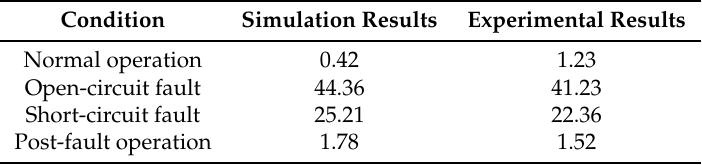
Table 5. Harmonic spectrum results.